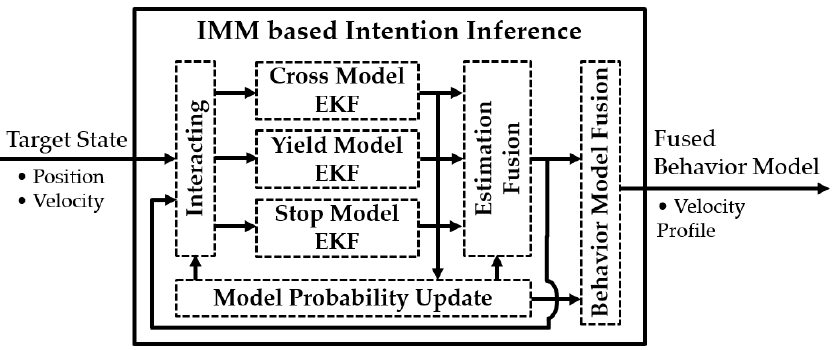
Figure 4. Block diagram of IMM-based target intention inference algorithm. The first step of designing the IMM filter is defining the behavior model for local EKF. The ‘Cross’, ‘Yield’, and ‘Stop’ models are defined based on the collected driving data. The data were collected at Midan City, Incheon, South Korea. The velocity profiles of the collected driving data are described in Figure 5. As shown in Figure 5, am asymmetric characteristic of the acceleration usage has been observed, which is biased to braking. Therefore, the IDM has been selected to model the asymmetric acceleration profile [26]. car-following behavior term, as follows: